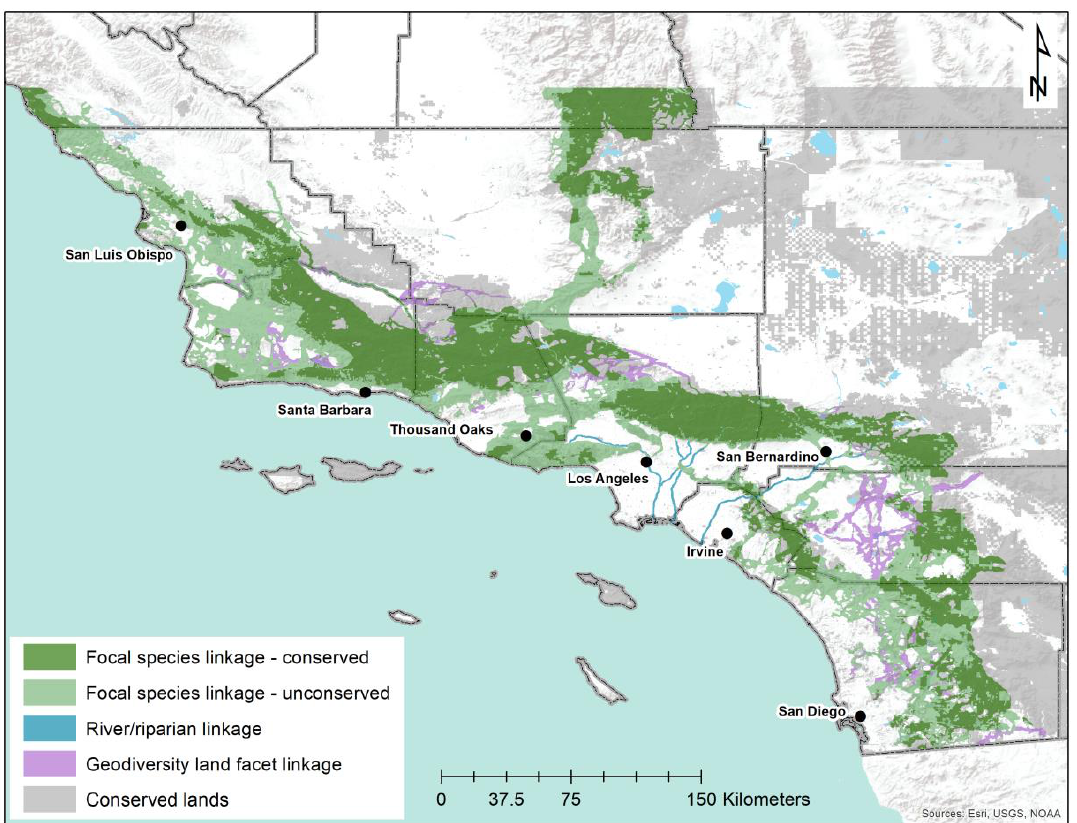
Figure 5. Final multispecies linkage map with different linkage types identified by the source for each type. Focal species linkages were derived from species-based modeling. Map depicts the full linkage network including large blocks of conserved lands important for climate connectivity and linkage segments yet to be conserved. River / riparian linkages follow major drainages to provide urban linkages. Finally, the geodiversity land facet linkages represent valleys and narrow valleys corridors that were added to complement the species-based linkages.